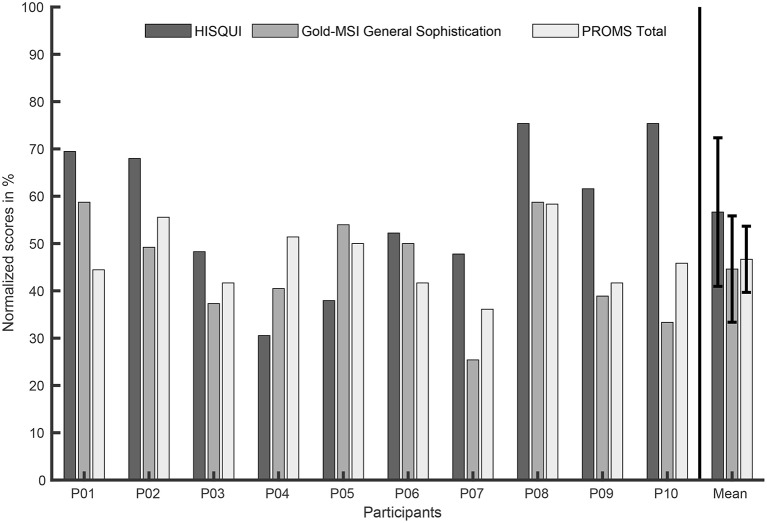
HISQUI, Gold-MSI General Sophistication, and PROMS Total scores per participant as main results from these questionnaires. The very right bars depict the mean and the standard deviation of each score for all participants. All scores were normalized to the maximum values of their respective scales (HISQUI: 203, Gold-MSI: 126, PROMS: 36).